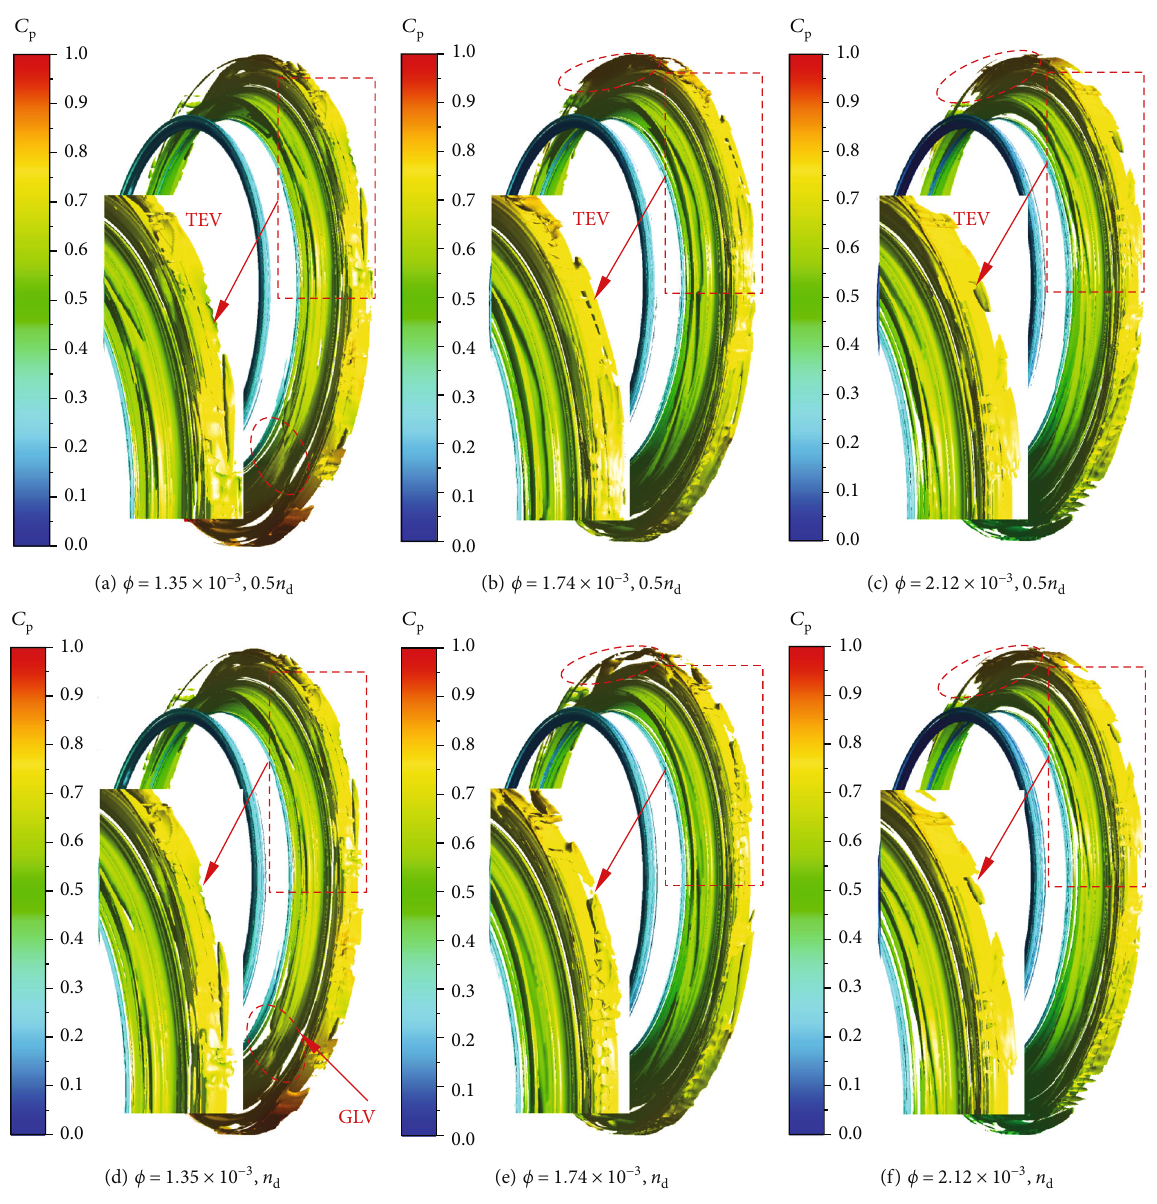
Figure 15: Comparison of the vortex under di ff erent rotational